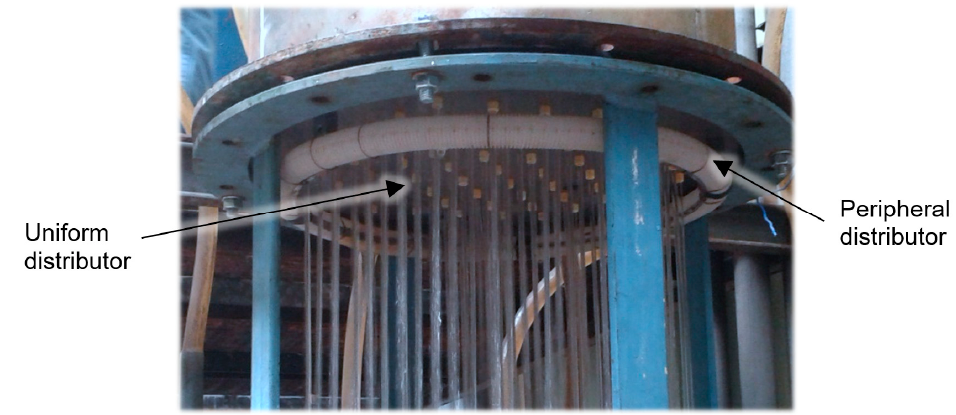
Figure 3. Photography of the uniform distributor operation.